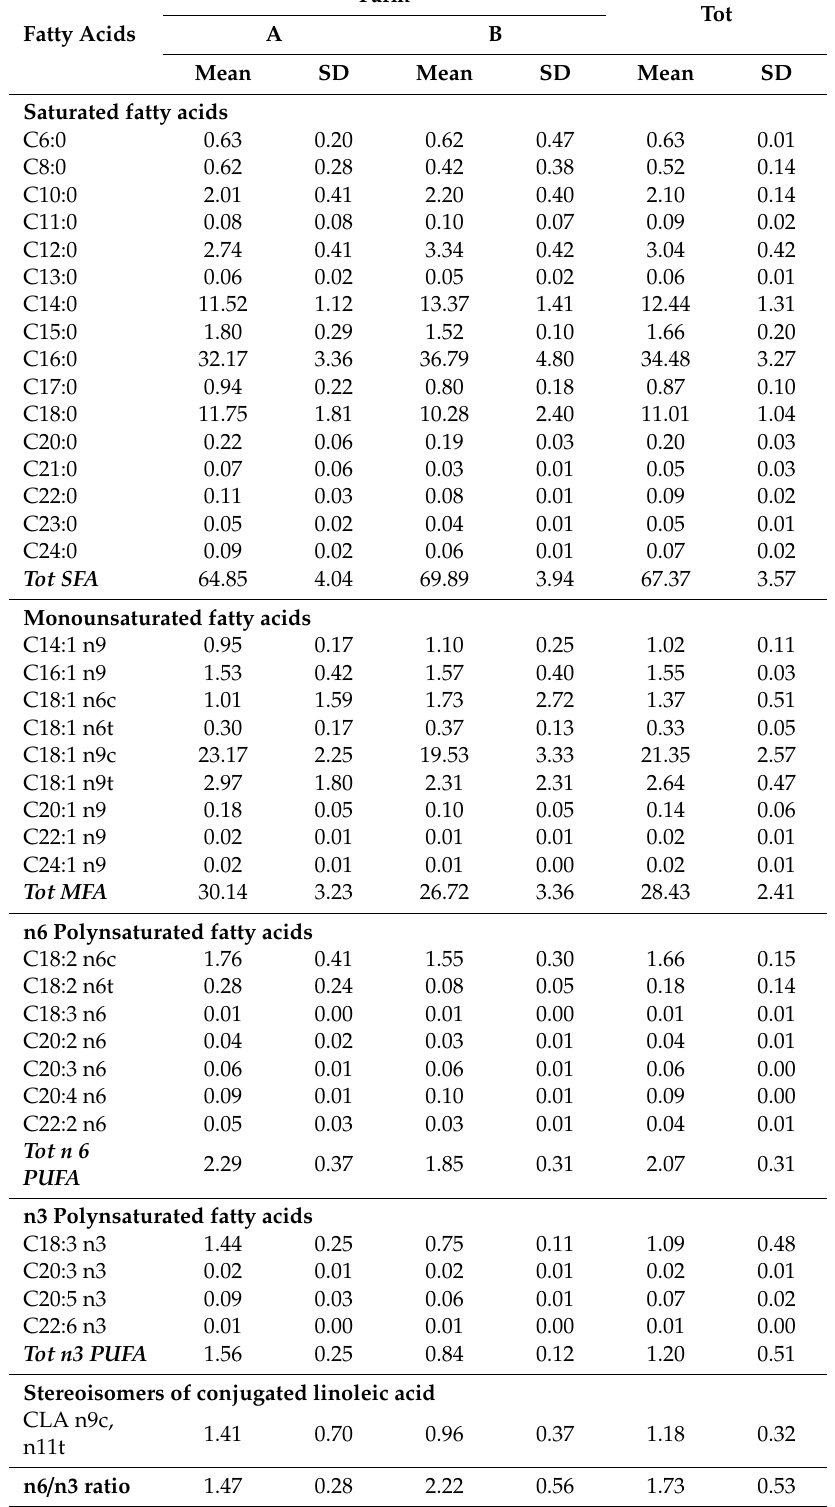
Table 1. Mean and standard deviation (SD) of detected fatty acids in milk from A (grazing system) and B (no-grazing system)